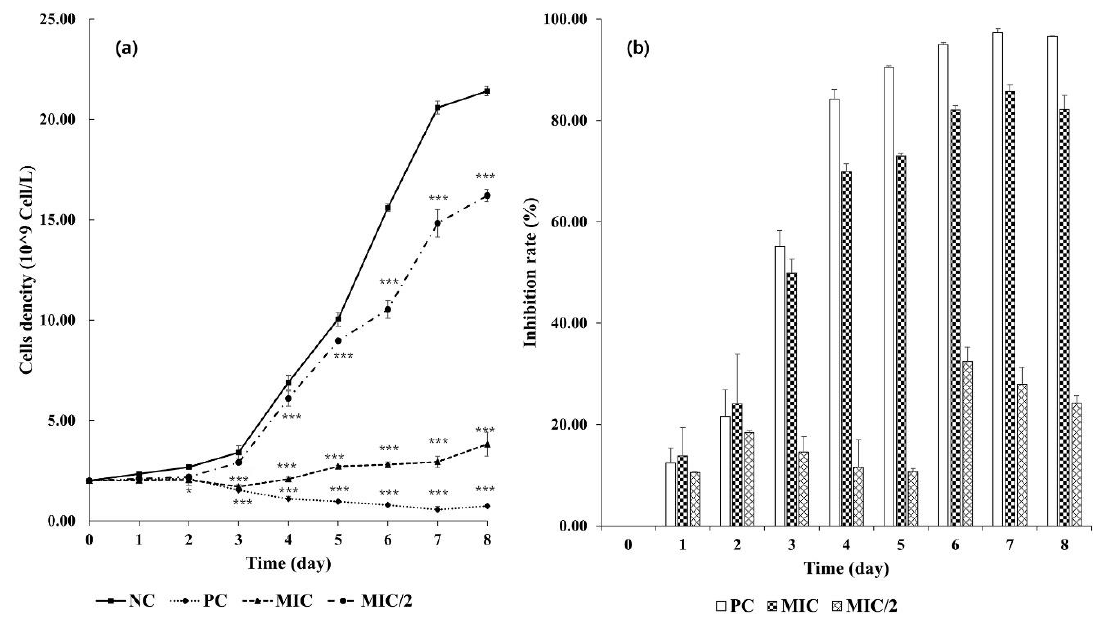
Figure 1. Effect of R. aquatilis aqueous extracts on the growth of M. aeruginosa . ( a ) cell density in 10 9 Cell/L and ( b ) inhibition rate in percentage. Each value is the mean ± SD of three replicates. * p < 0.05 and *** p < 0.001 indicate significant differences between the treatments and the negative control (one-way ANOVA) in ( a ). NC: negative control; PC: positive control; MIC: minimal inhibitory concentration and MIC/2: half MIC concentration.